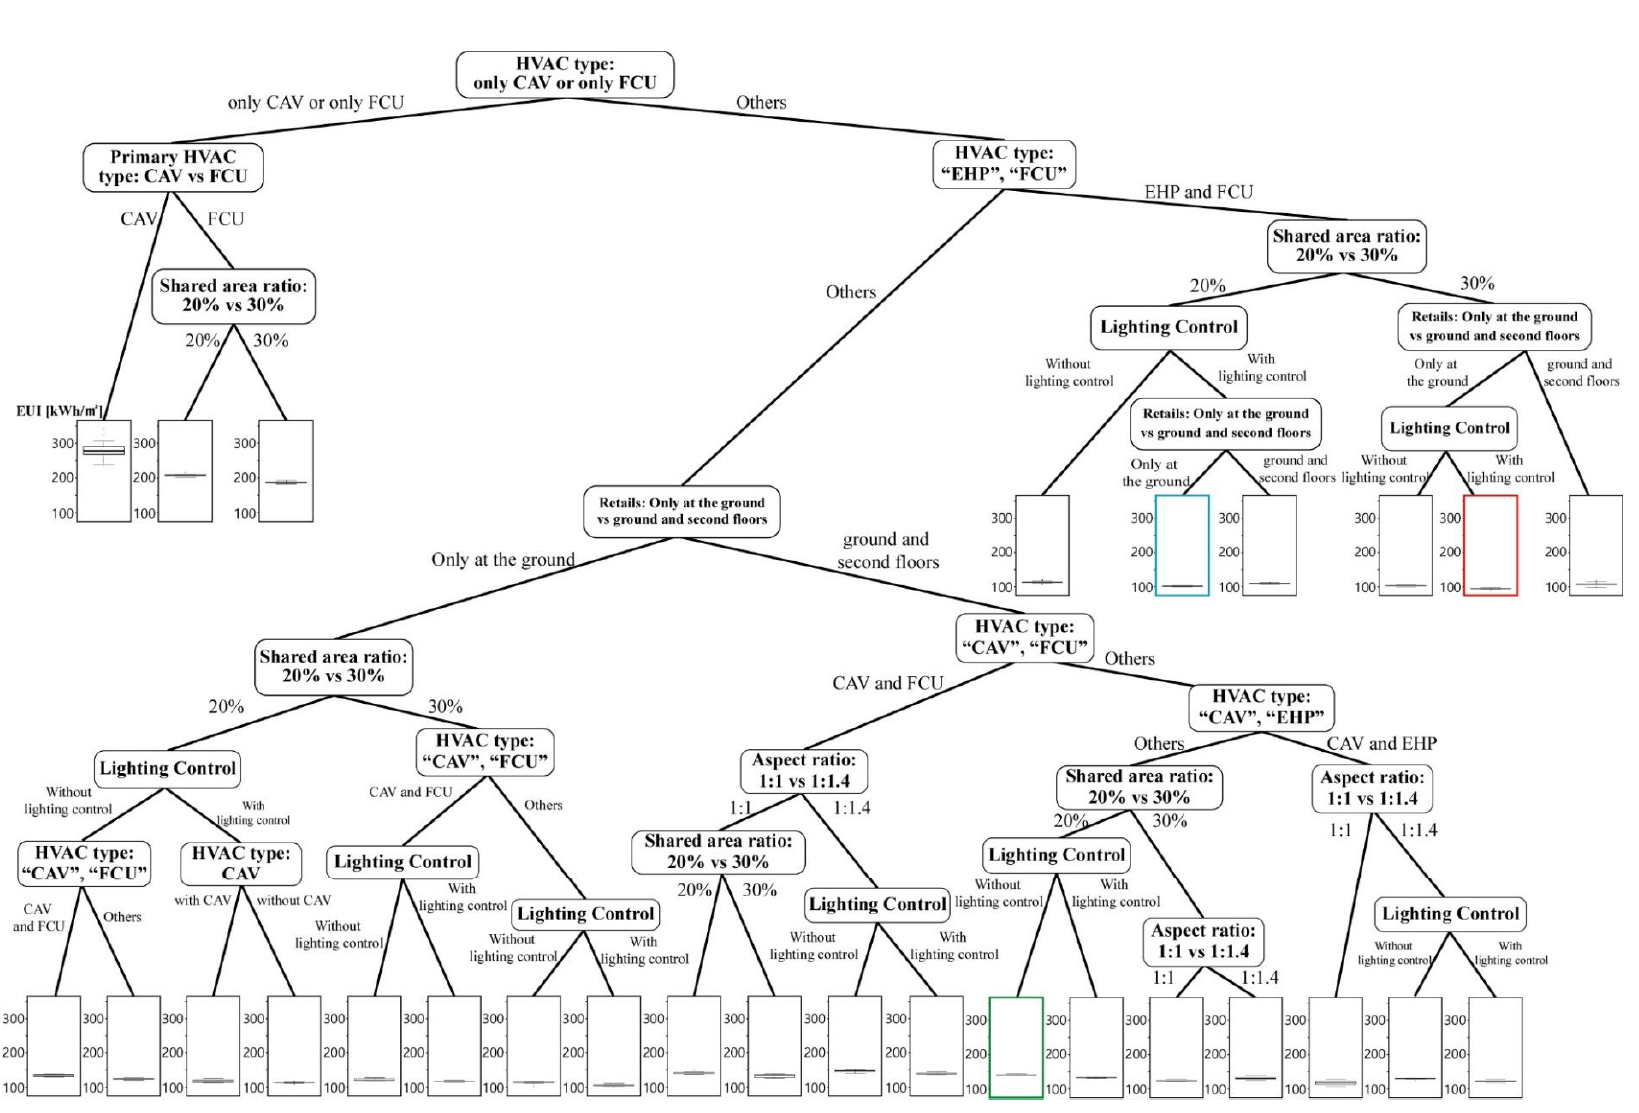
Figure 6. Decision support model by CIT.